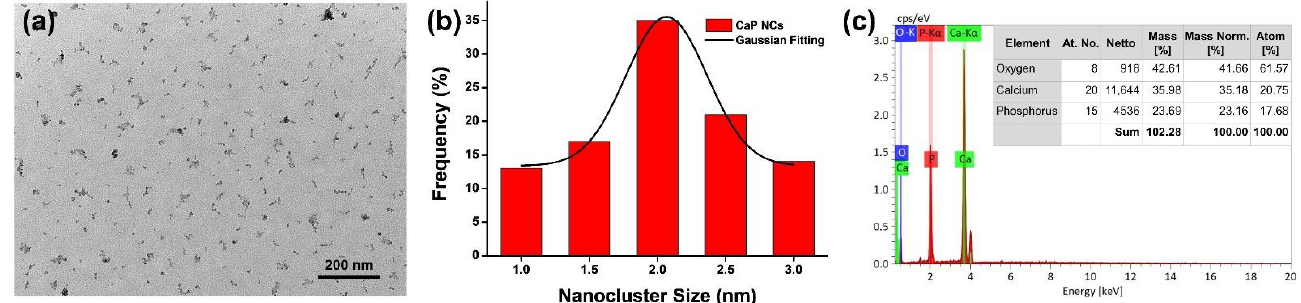
Figure 1. ( a ) TEM image of calcium phosphate nanoclusters (CaP NCs). ( b ) Histogram of the size distribution of CaP NCs and its Gaussian fitting curve. ( c ) EDX analysis of CaP NCs.